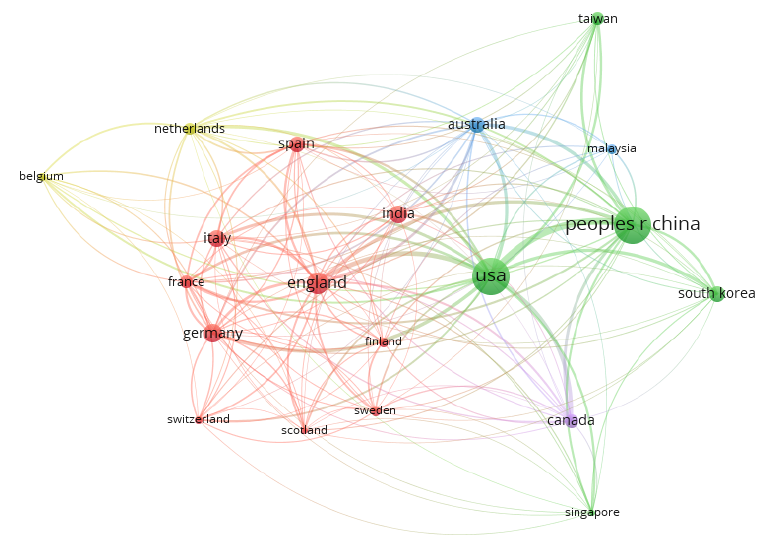
Figure 4. Co ‐ authorship network by country. Figure 4. Co-authorship network by